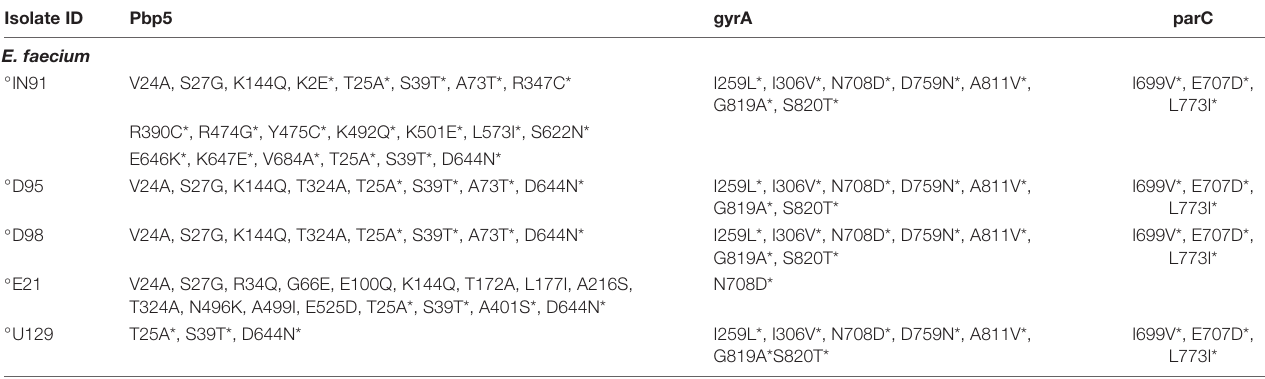
TABLE 2 | Point mutation in the gyrA , parC (quinolone resistance), and pbp5 (ampicillin resistance) genes in environmental Enterococcus